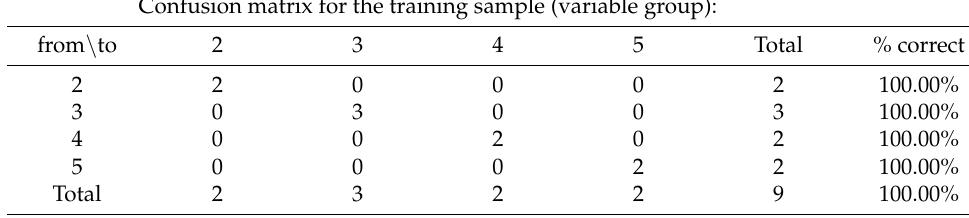
Table 5. Classification results of the classes computed by PLS-DA for training sample and validation